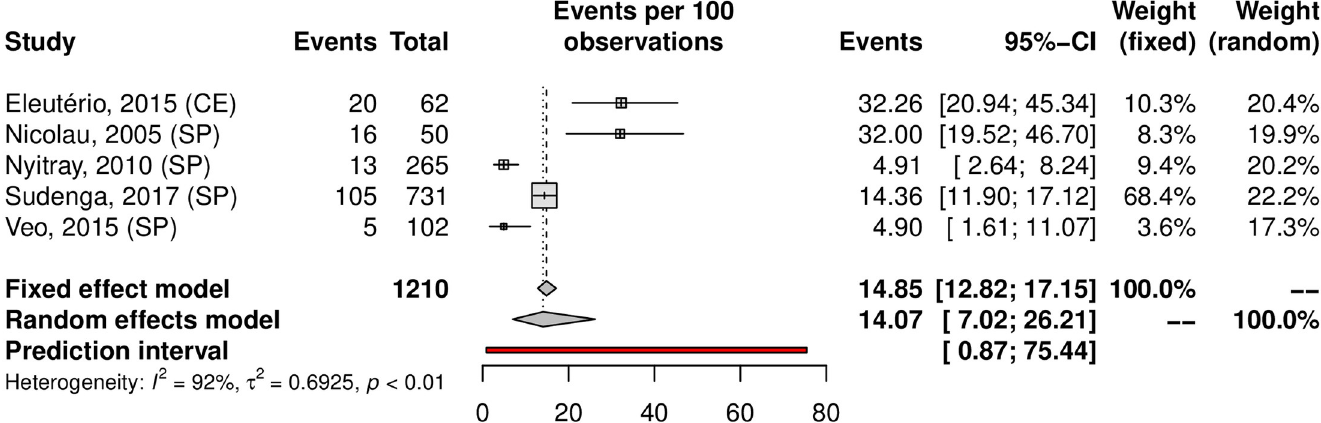
Fig 17. Overall prevalence of anal infection by high-risk HPV genotypes. Forest plot of a metanalysis of studies reporting prevalence of anal infection by HR-HPV in Brazil.